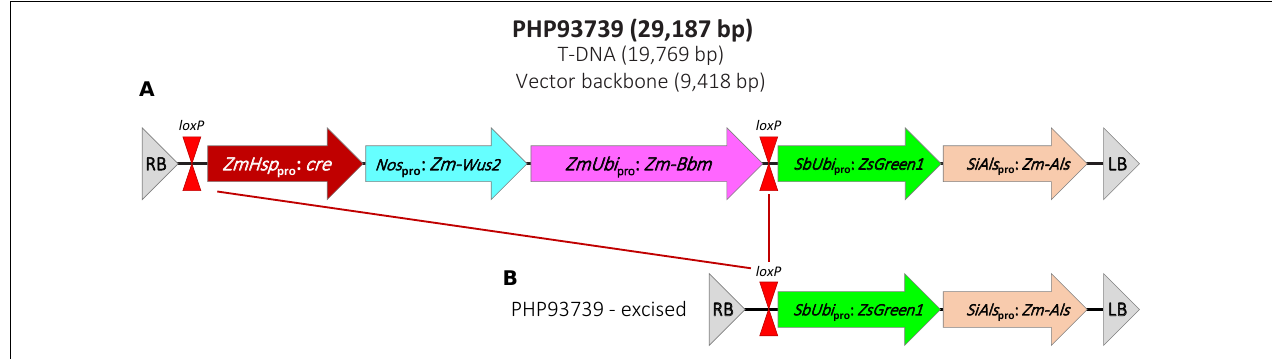
FIGURE 1 | Schematic illustration of the construct PHP93937 used for all transformation experiments. (A) T-DNA region of PHP93739. RB, T-DNA right border; loxP , CRE recombinase target site; ZmHsp pro : cre , maize heat shock protein 17.7 promoter ( Zm-Hsp17.7 ) + cre gene + potato proteinase inhibitor II ( pinII ); Nos pro : Zm-Wus2 , Agrobacterium nopaline synthase promoter ( Nos ) + maize Wuschel2 gene ( Zm-Wus2 ) + maize In2-1 terminator; ZmUbi pro : Zm-Bbm , maize ubiquitin promoter/intron ( ZmUbi ) + maize Baby boom gene ( Zm-Bbm ) + maize ubiquitin terminator ( Zm-Ubi ); SbUbi pro : ZsGreen1 , sorghym ubiquitin promoter/intron ( SbUbi ) + green fluorescent protein ZsGreen1 gene + rice ubiquitin terminator ( OsUbi ); SiAls pro : Zm-Als , Setaria italica acetolactase synthase ( SiAls ) promoter + maize Als ( Zm-Als ) gene + sorghum ubiquitin terminator ( Sb-Ubi ); LB, T-DNA left border. (B) T-DNA region in transgenic plant after the heat-treatment to remove the morphogenic genes and cre